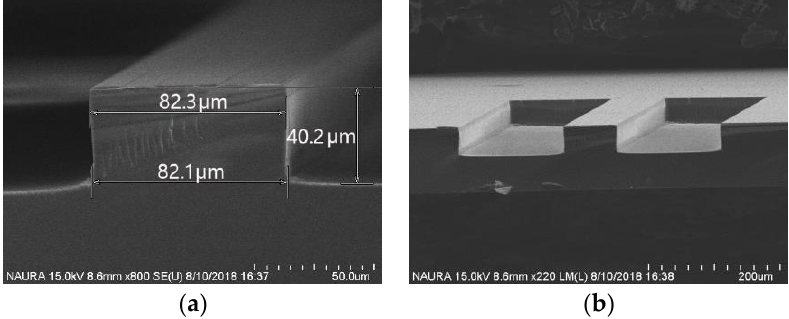
Figure 11. SEM image of the quartz etching structure: ( a ) SEM photograph of the cross-sectional view of the etching structure and ( b ) SEM photograph of the overall view of the etching structure.